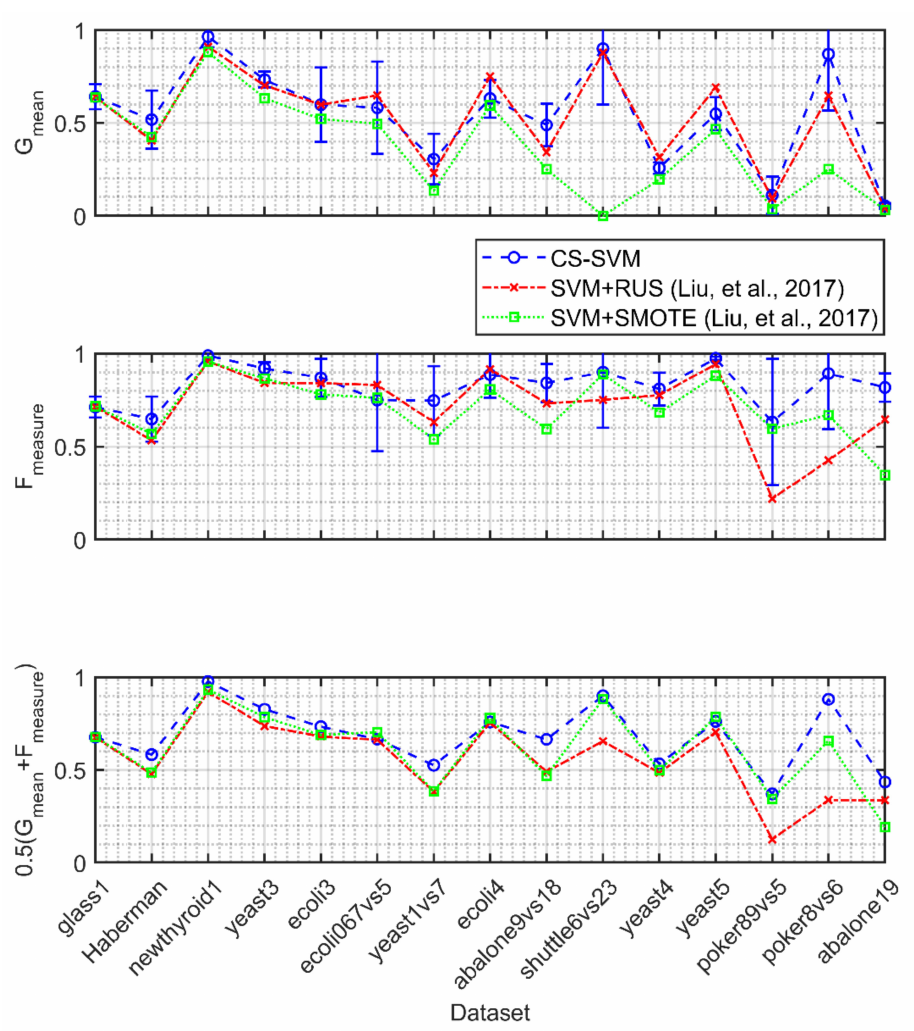
Figure 3. Comparison between the classification performances of the CS-SVM, SVM based on RUS and SVM based on